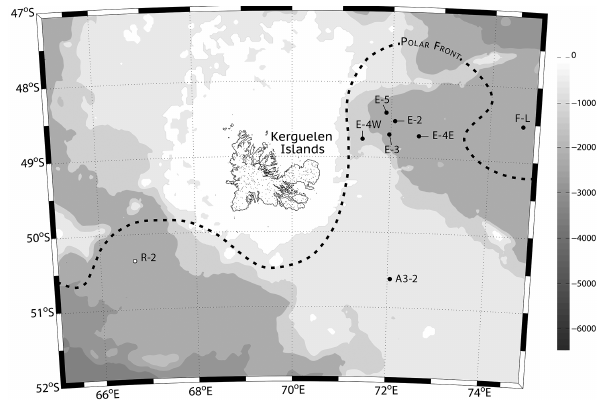
Figure 1. Map of the KEOPS2 study area showing the stations sam- pled for Fe uptake experiments. The dashed line represents the po- sition of the polar front. The base map shows the bathymetry in